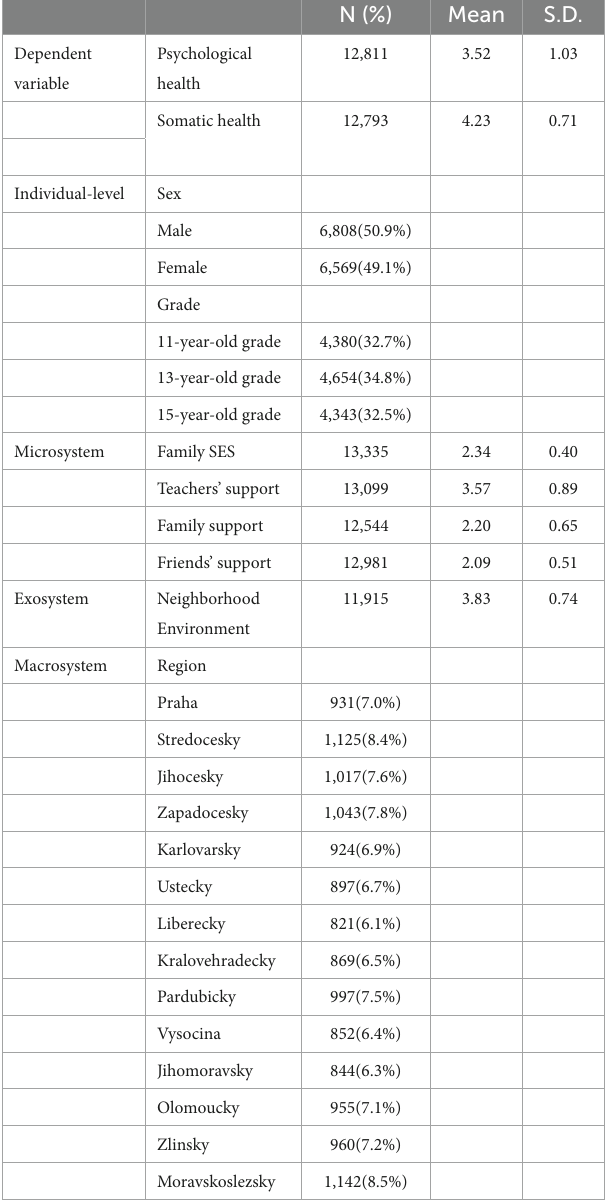
TABLE 1 Descriptive statistics for sample characteristics and the Chi- square test between independent factors and adolescents’ psychological/ somatic